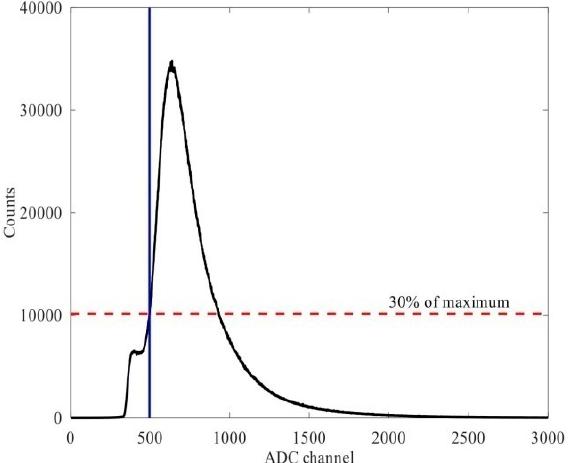
Figure 2. Scintillator energy spectra discrimination procedure to eliminate fluctuations in the threshold level and signal gain. The black curve is the scintillation detector spectrum with a fixed threshold level set to the 300th ADC channel; the red dashed line represents 30% of the maximum number of counts registered in one channel in the given spectrum. The blue vertical line indicates the ADC channel defining the normalized discrimination level. The part of the spectrum below this channel is not used in further analyses.